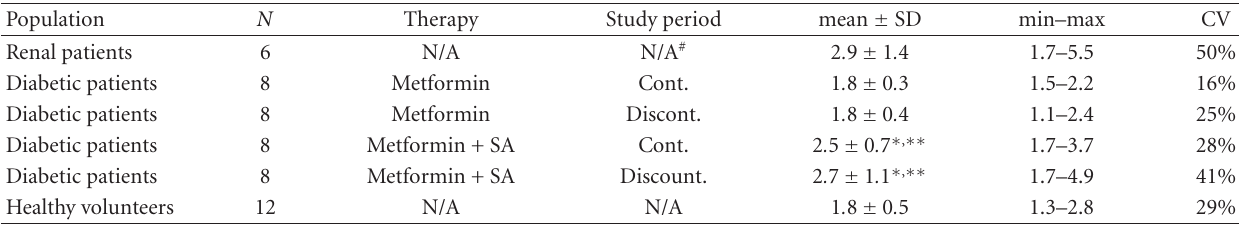
Table 3: Reactive hyperaemia index.